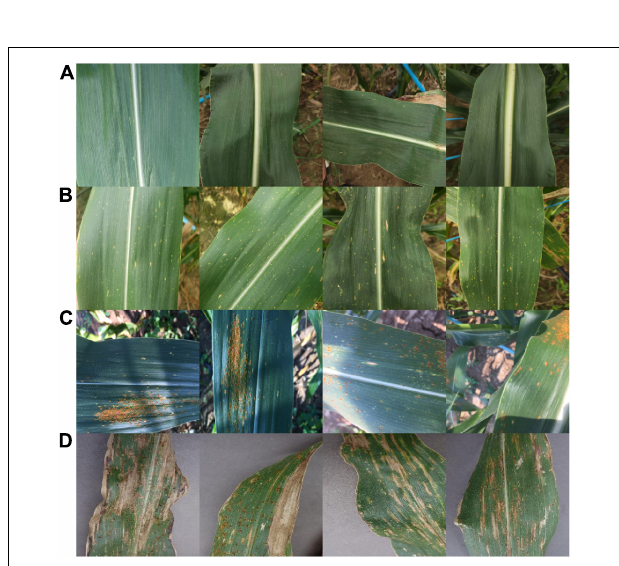
FIGURE 2 | Showing four categories of samples of maize. (A) H. (B) SCLB. (C) SR. (D)